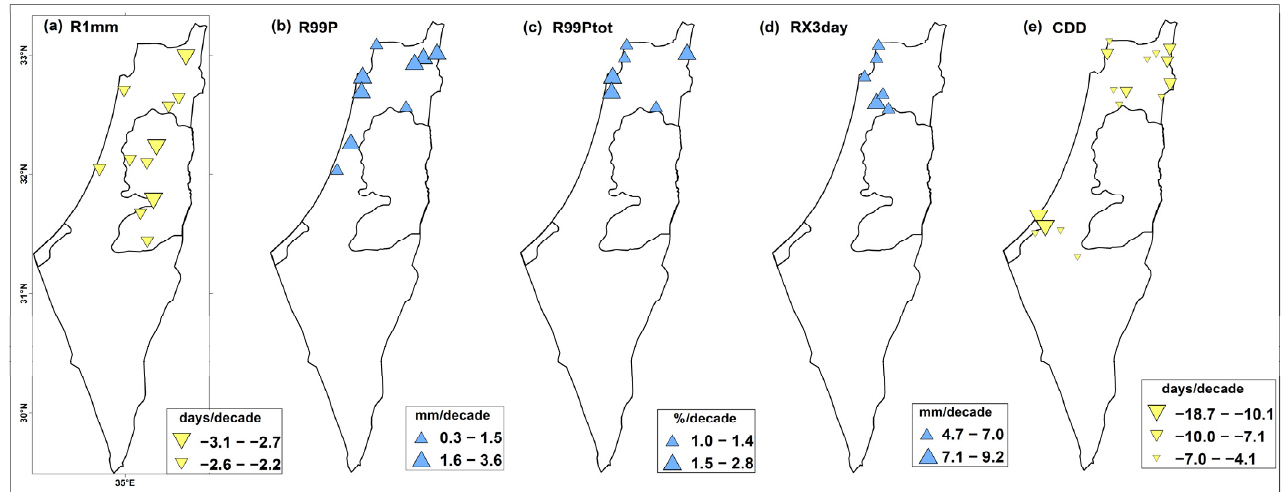
Figure 2. Spatial distribution of trends for the number of wet days (R1mm in days/decade), extremely wet days (R99P in mm/decade), contribution from extremely wet days (R99Ptot in %/decade), max 3-day precipitation amount (RX3day in mm/decade), and consecutive dry days (CDD in days/decade) indices exhibiting notably significant decreasing (yellow triangles) or increasing (blue triangles) trends at the 95% confidence level.